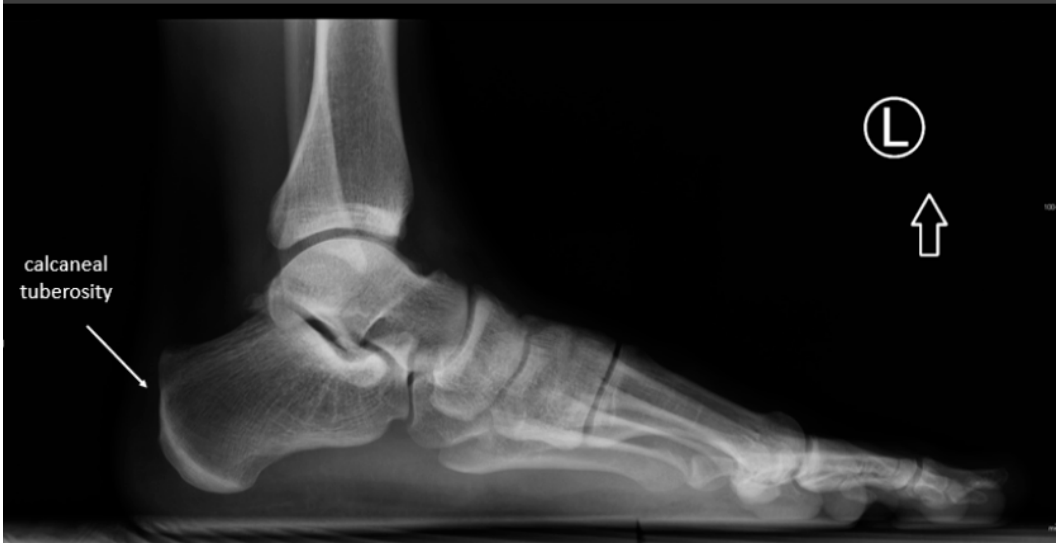
Figure 3. X-ray image of the flat shape of the calcaneal tuberosity.